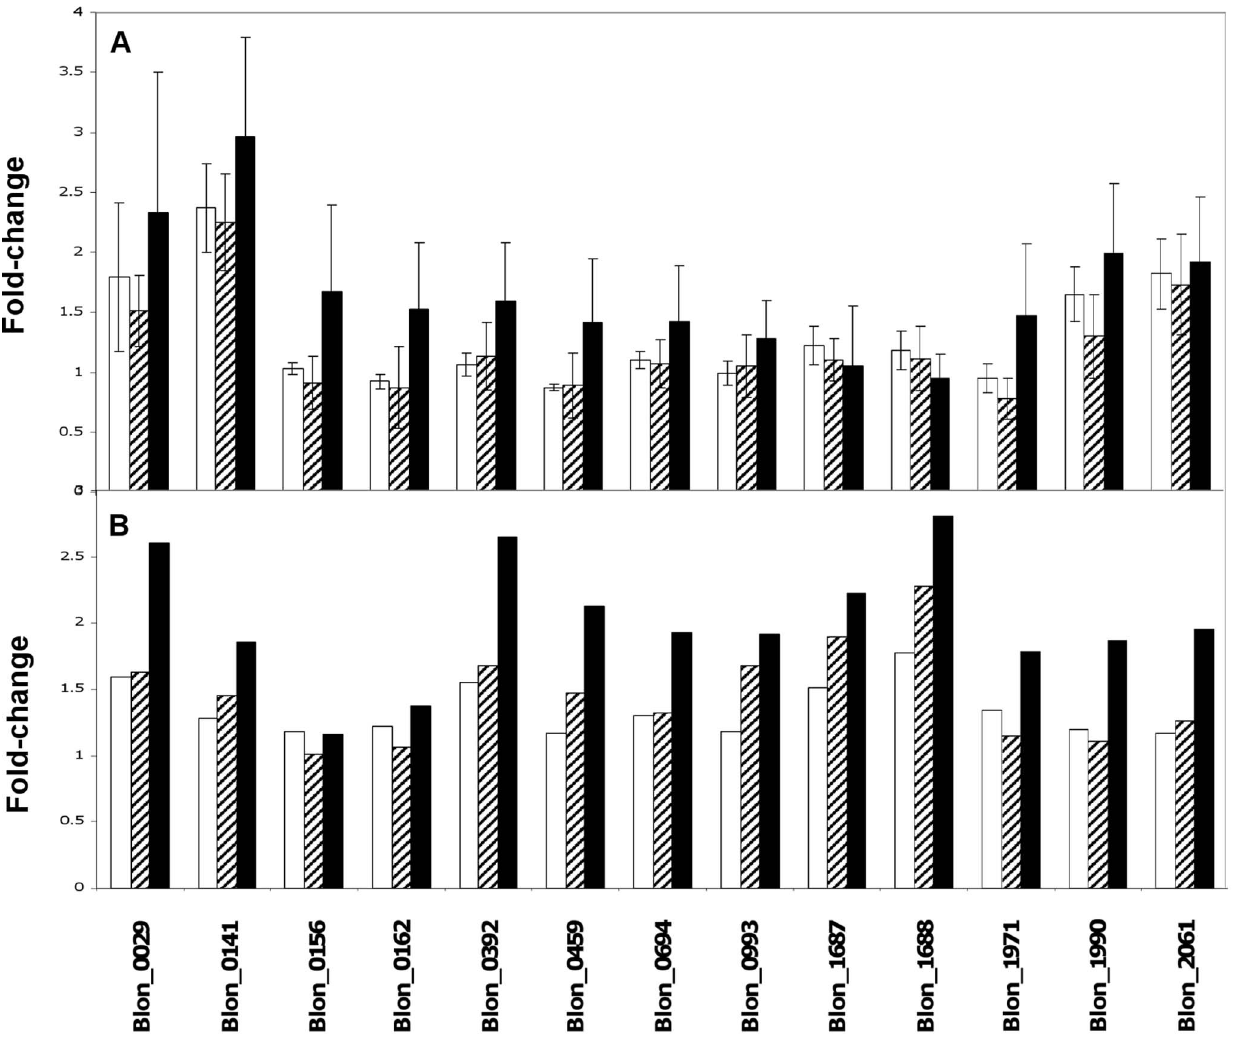
Figure 7. Transcript levels for thirteen (13) selected genes as determined by qPCR (A) and microarray analysis (B). 3 9 sialyllactose (white shading); 6 9 sialyllactose (black and white diagonal shading); 3 9 - and 6 9 -sialyllactose mixture (black shading). Blon_0029– Ferritin; Blon_0141 - Chaperonin protein DnaK; Blon_0156 - TadE family protein; Blon_0162– Sortase; Blon_0392 - Cation efflux protein;Blon_0459 - Glycoside hydrolase, family 20; Blon_0694– GroEL; Blon_0993 - Magnesium-translocating P-type ATPase; Blon_1687 - TfoX, C-terminal domain protein; Blon_1688 - Transcription activator, effector binding; Blon_1971 - High-affinity zinc ABC transporter; Blon_1990 - Glycine dehydrogenase; Blon_2061– Extracellular solute binding protein.